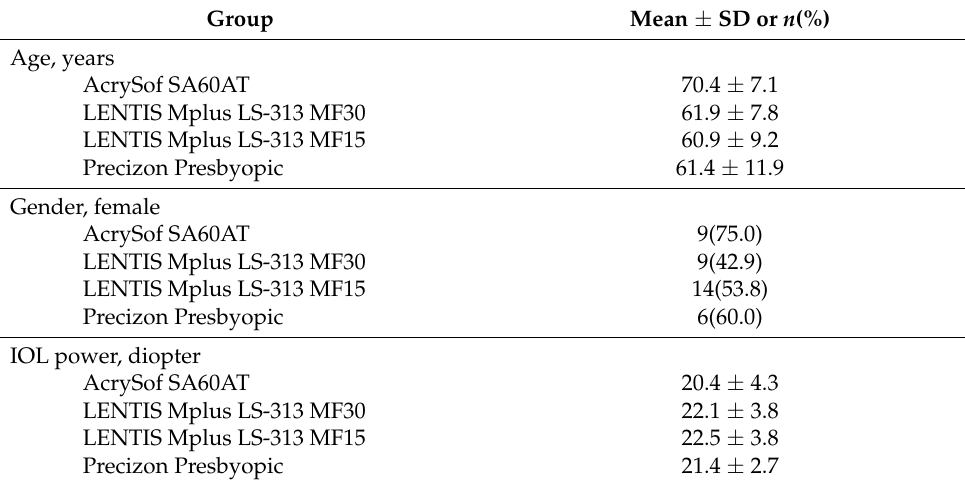
Table 1. Summary of studied